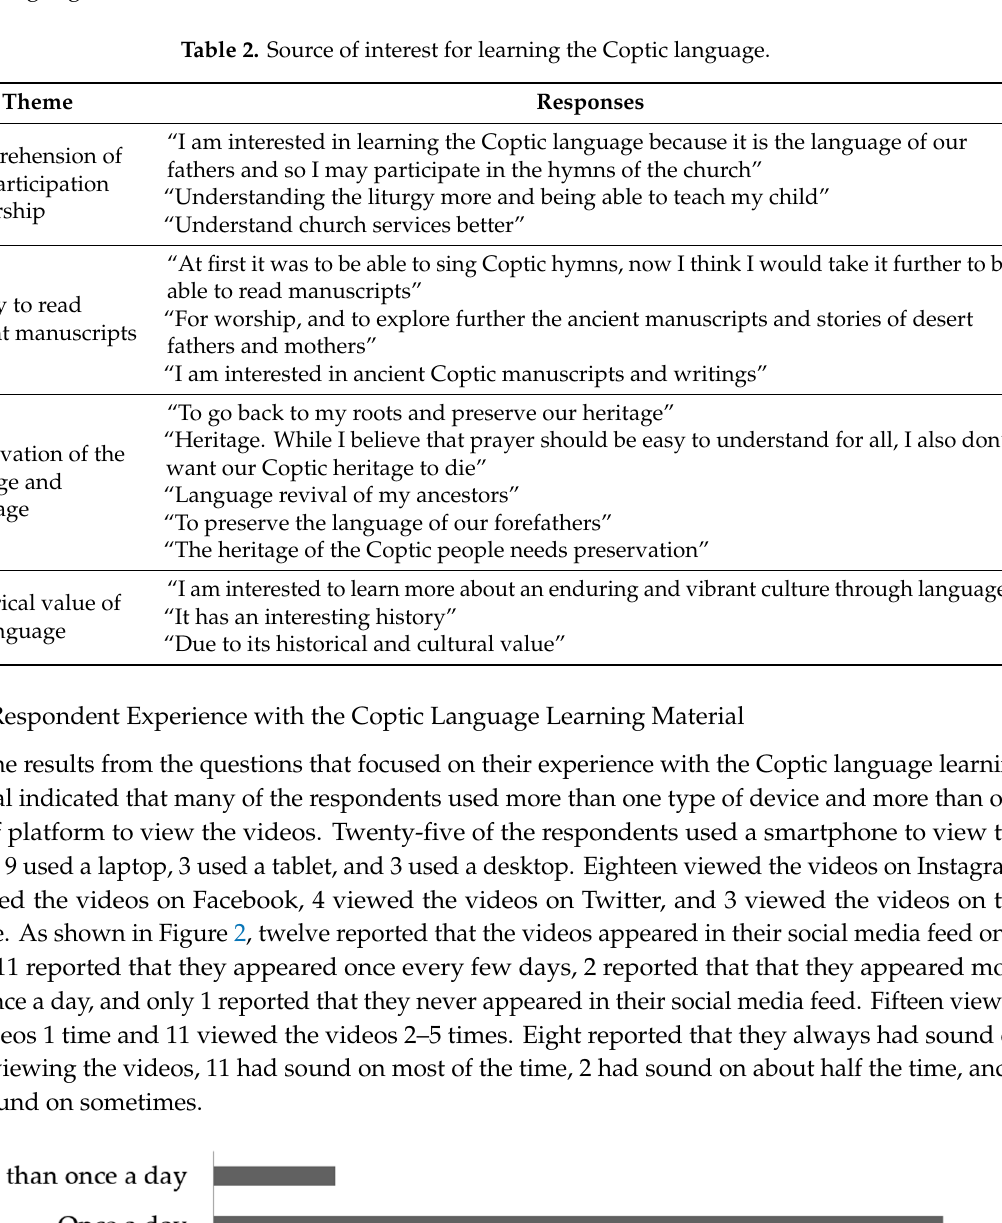
Table 2. Source of interest for learning the Coptic language.